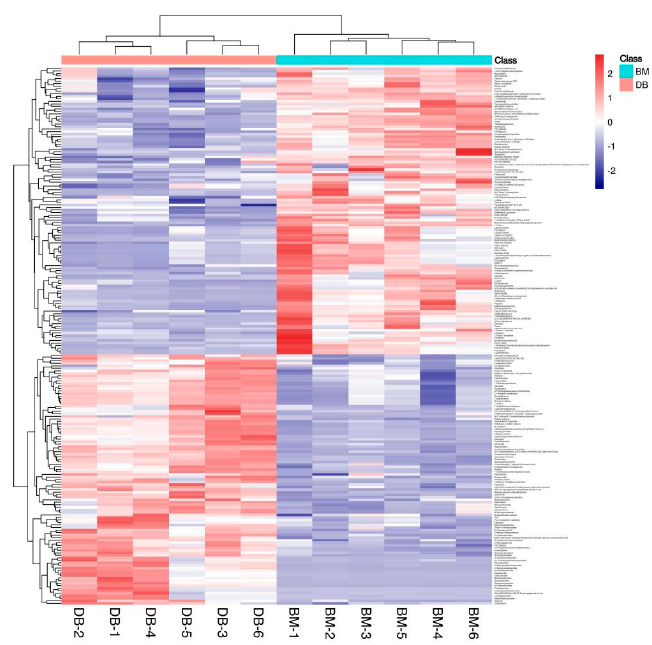
Figure 3. The differential metabolite heat map showed the differences between the two